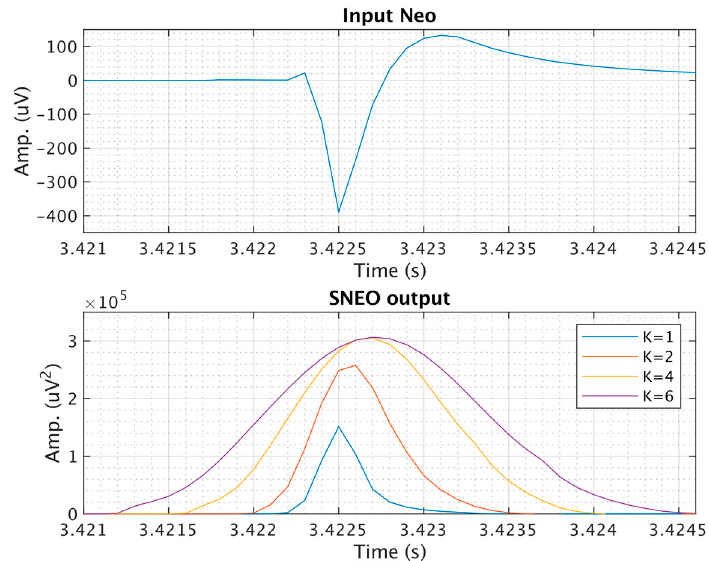
Figure 3. The smoothed non-linear energy operator (SNEO) output at different resolution parameters considering a noiseless spike as input.